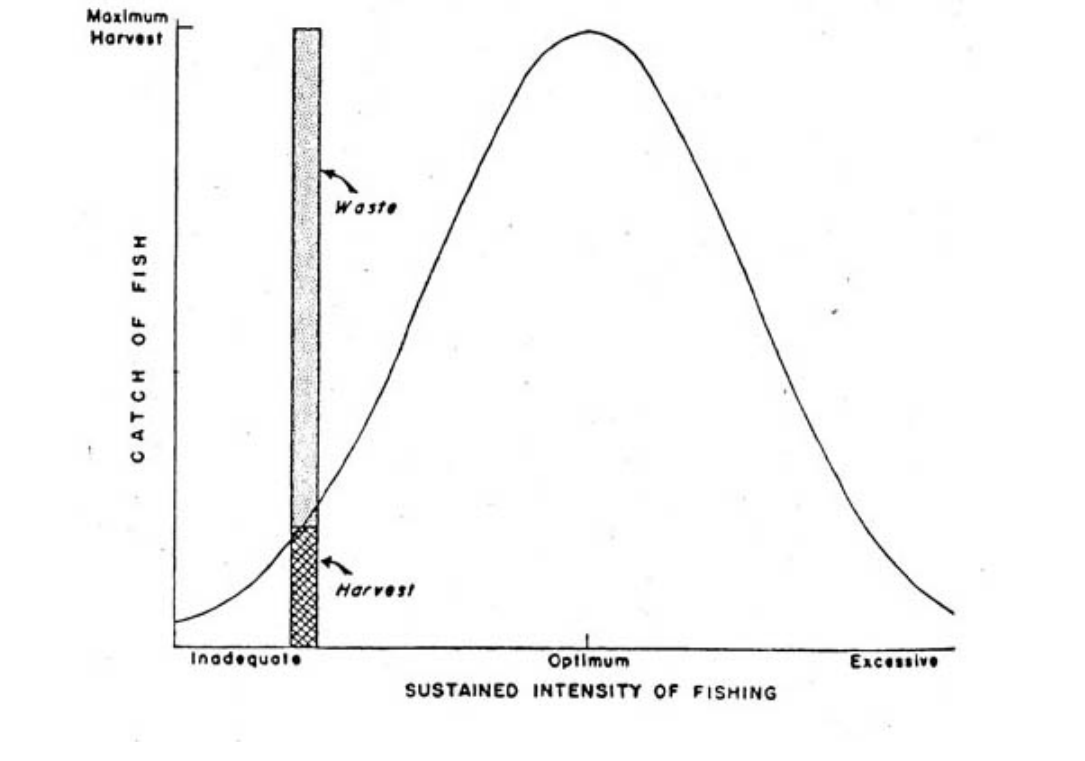
Fig. 1. Chapman’s graph, published in the U.S. High Seas Fisheries Policy, U.S. Department of State Bulletin XX: